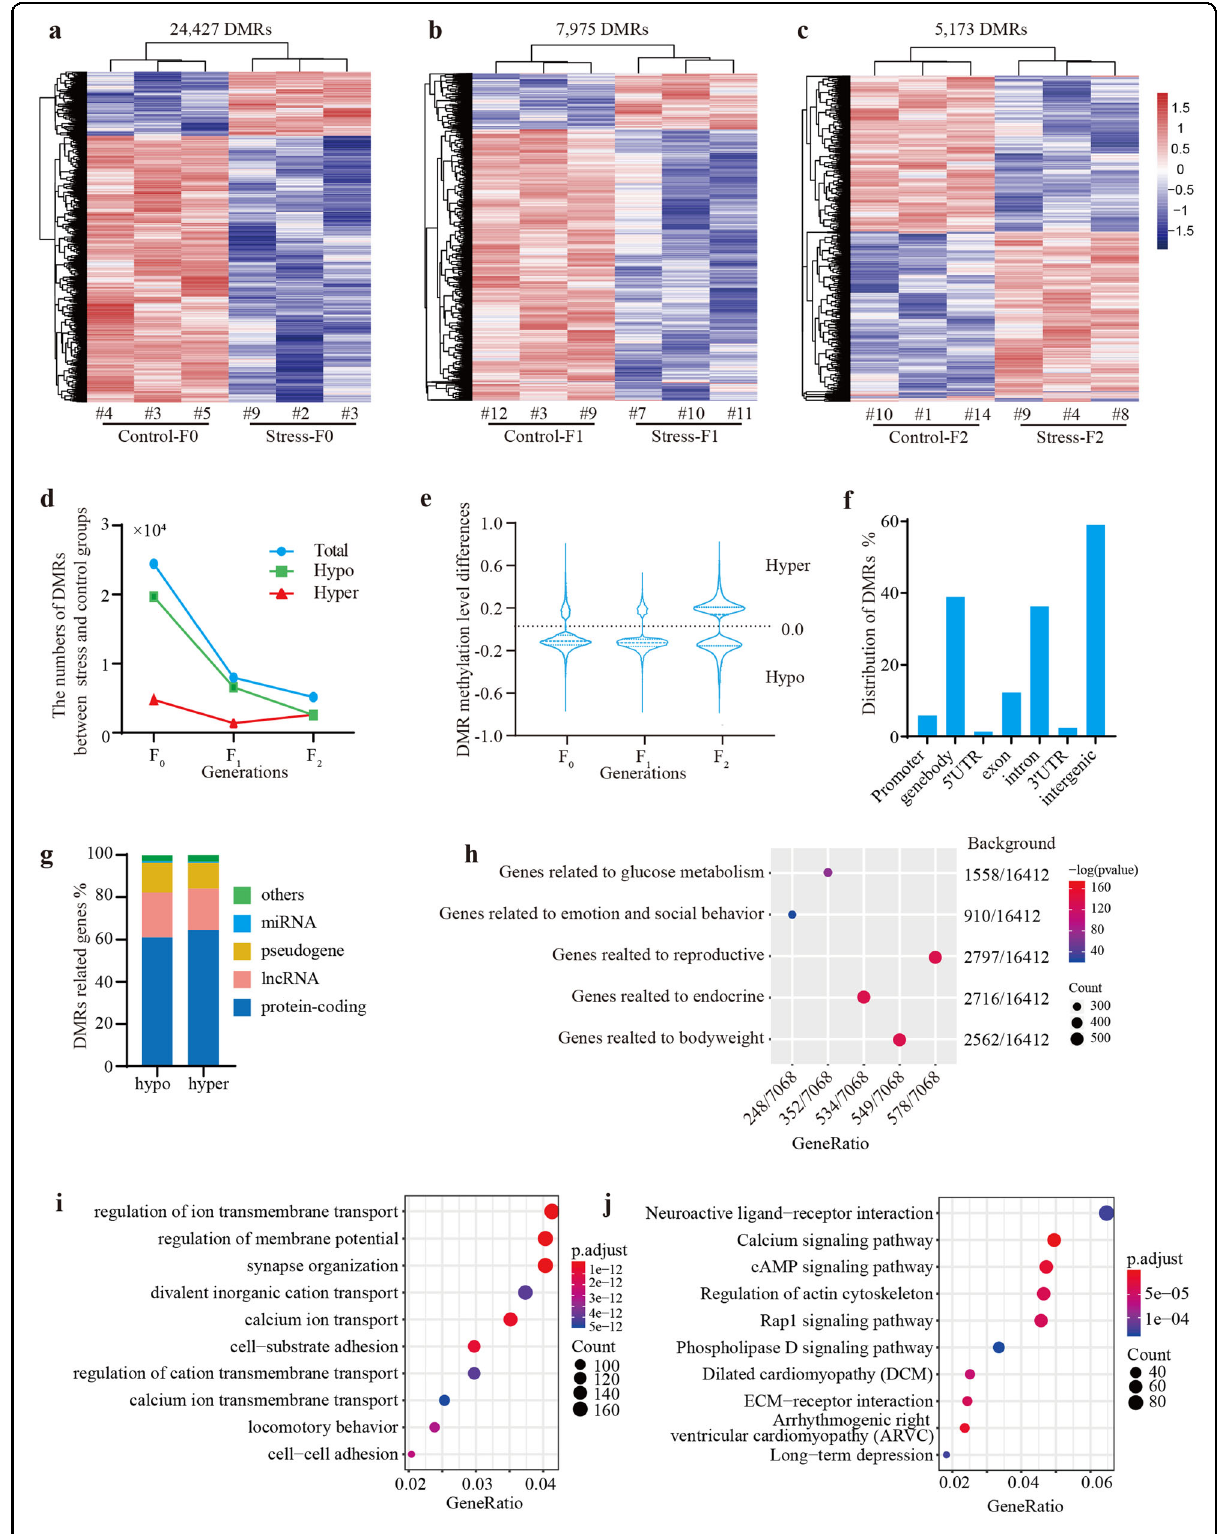
Fig. 2 (See legend on next